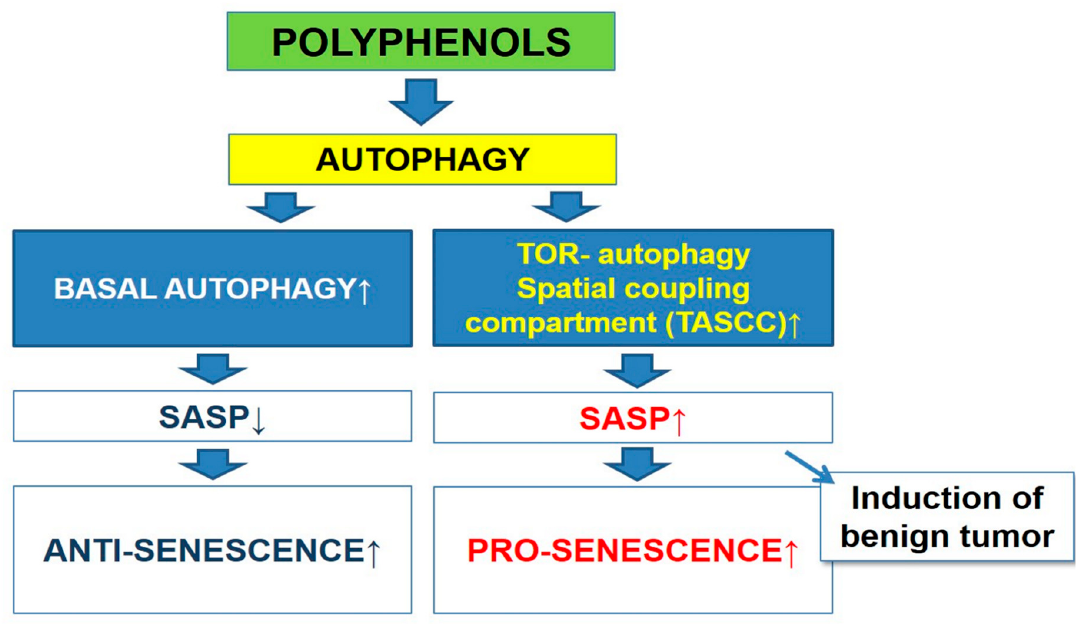
Figure 2. The scheme of relationship between autophagy and senescence-associated secretory phenotype (SASP).